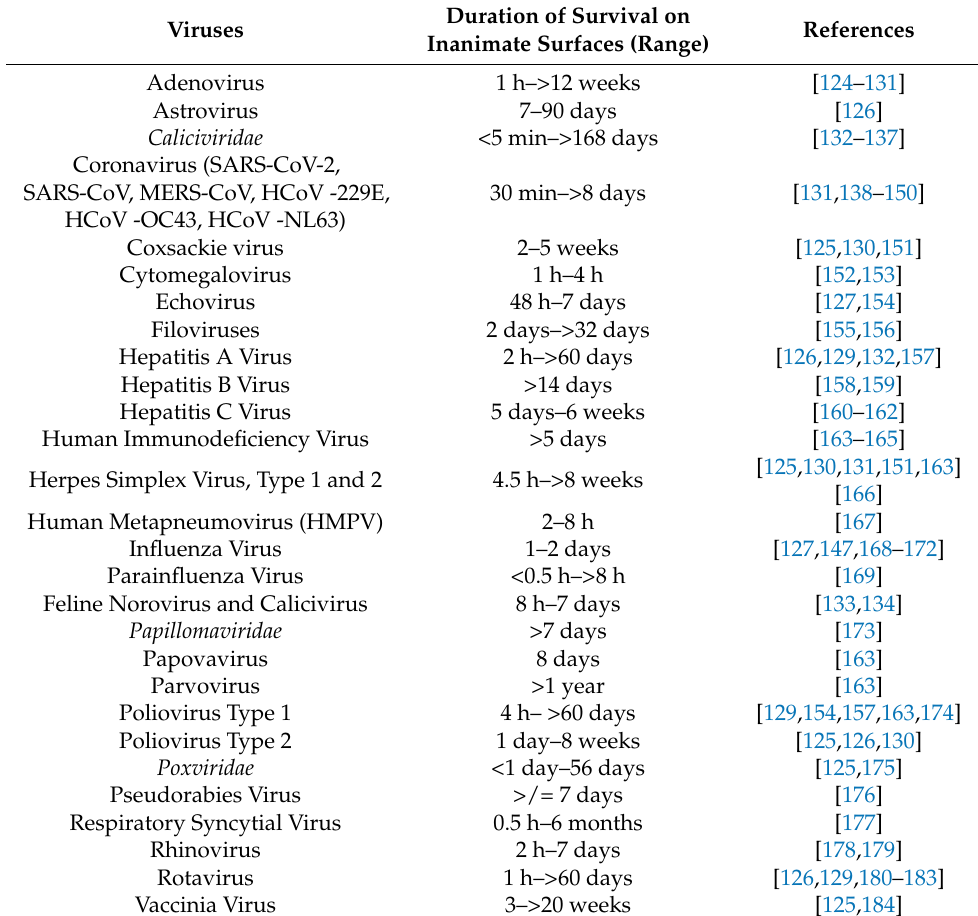
Table 2. Viruses detected in fomites and hospital environments, their survival and